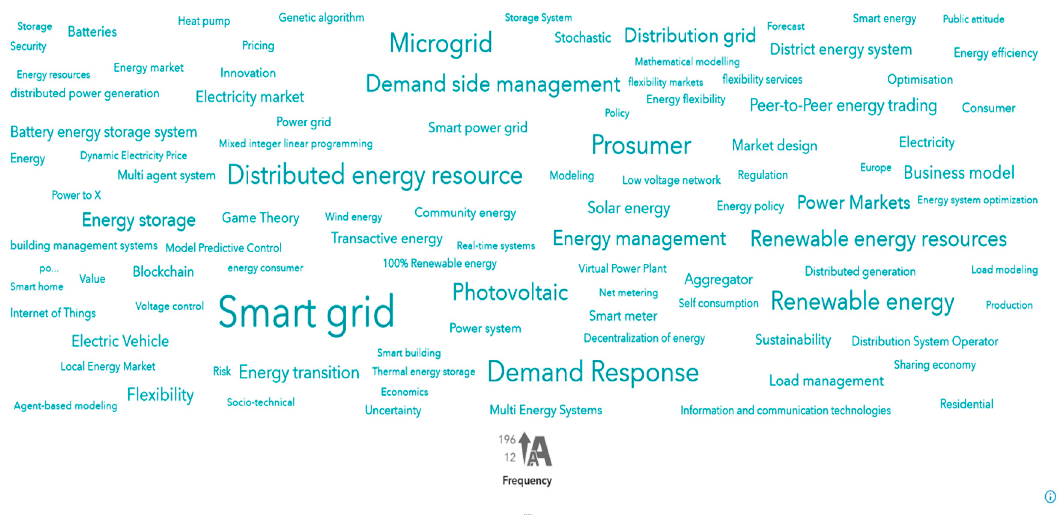
Figure 10. Keyword analysis by SAS Viya.